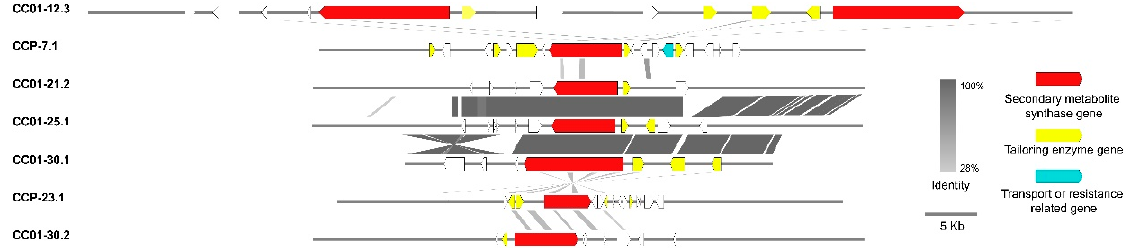
Figure 9. Synteny analysis of PKS/NRPS gene clusters in C. cassiicola CC01 and CCP.